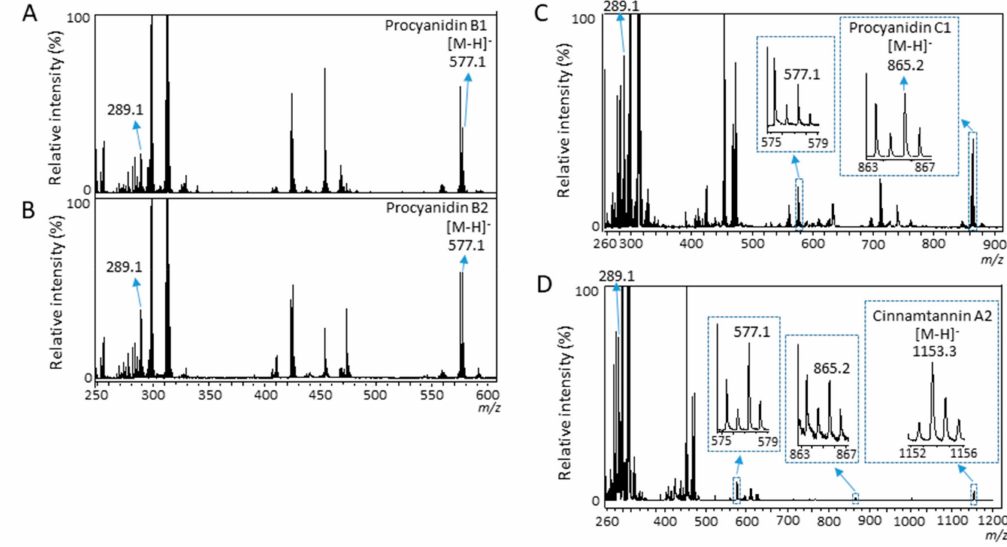
Figure 6. Matrix-assisted laser desorption / ionization-mass spectrometry analysis of procyanidin standards. Mass spectra of ( A ) procyanidin B1, ( B ) procyanidin B2, ( C ) procyanidin C1, and ( D ) cinnamtannin A2 standards. The peaks with m / z values indicate the peaks matching to identified flavan-3-ols in strawberry fruit